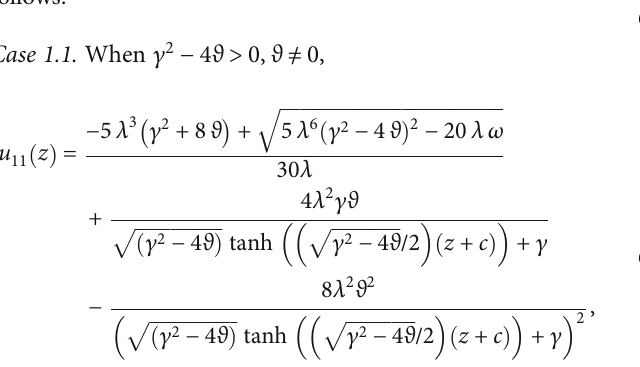
ffiffiffiffiffiffiffiffiffiffiffiffiffiffiffiffiffiffi 4 ϑ − γ 2 ð